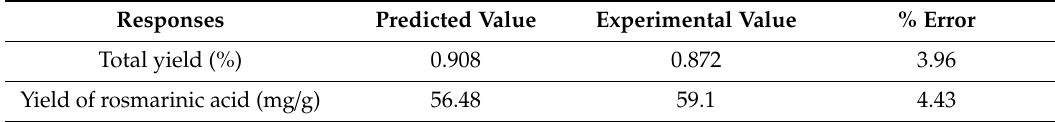
Table 4. Validation between predicted value and experimental